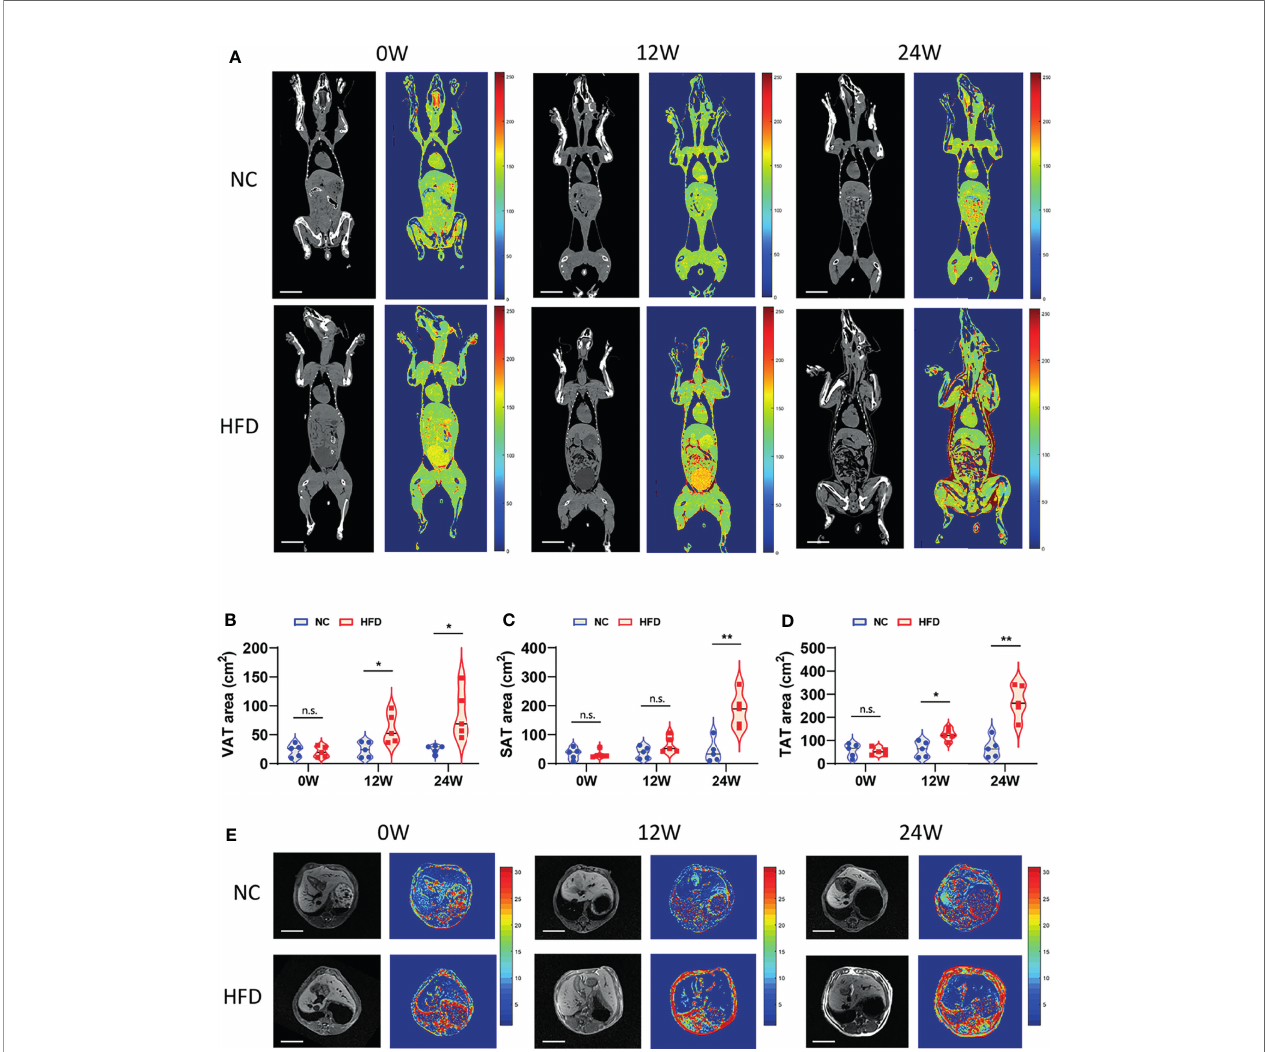
FIGURE 2 | Imageological diagnosis revealed the effects of long-term intake of HFD on the body fat content and distribution of animals. (A) CT image of the coronal plane of NC and HFD dogs at 0, 12 and 24 weeks. Grayscale and pseudocolor images suggested that abdominal fat content increased after HFD feeding for 12 weeks, while both subcutaneous fat and visceral fat had pronounced accumulation by 24 weeks. Scale bar, 10 cm. (B – D) The area of visceral adipose tissue (VAT) and subcutaneous adipose tissue (SAT) measured separately based on CT imaging and the total adipose tissue (TAT) area obtained by the summation. n = 5 per group. Data are expressed in the form of violin plot. n.s. represents not statistically signi fi cant. Signi fi cance levels * P <0.05, ** P <0.01. (E) Cross-sectional MRI at 0, 12 and 24 weeks shows clear changes in abdominal adipose tissue. Scale bar, 5 cm. In (A, E) , all the images shown in each row (NC or HFD) were obtained from the same individual